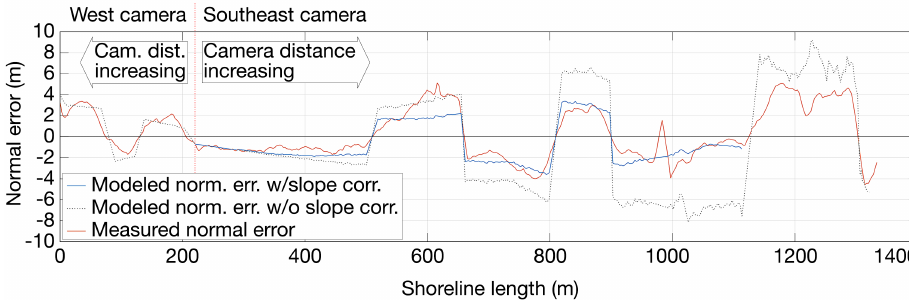
Figure 14. Estimated normal